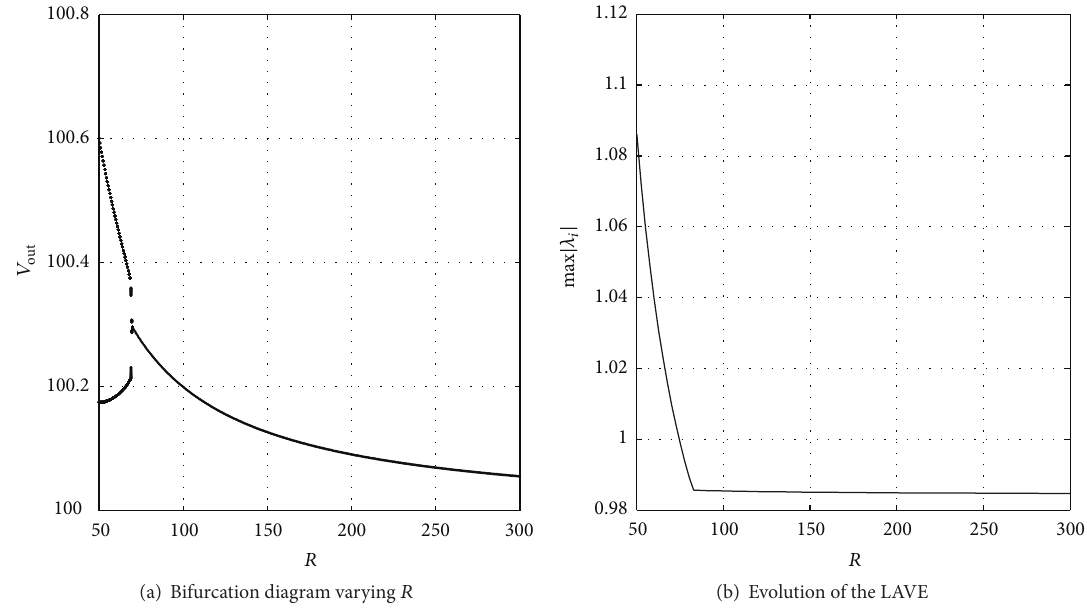
Figure 6: Steady state and stability of period-1 orbit as 𝑅 varies in [50,300]